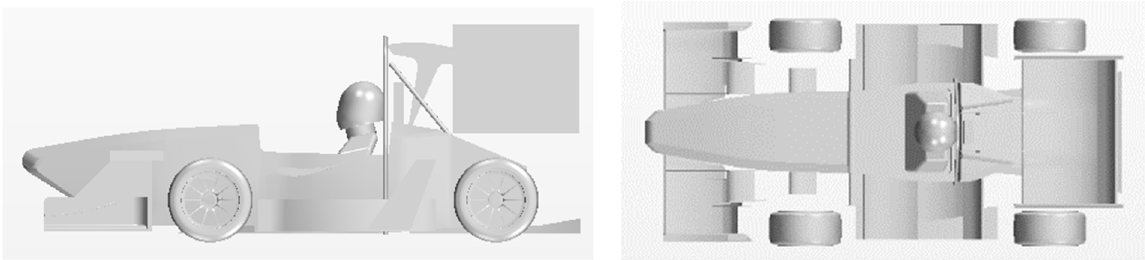
Figure 1. Simplified racing